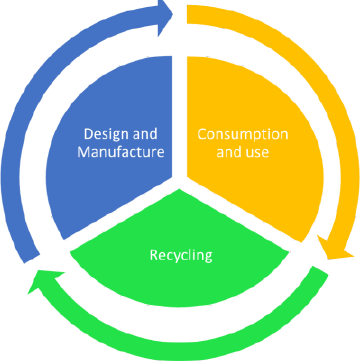
Figure 2. Circular economy flow diagram model.